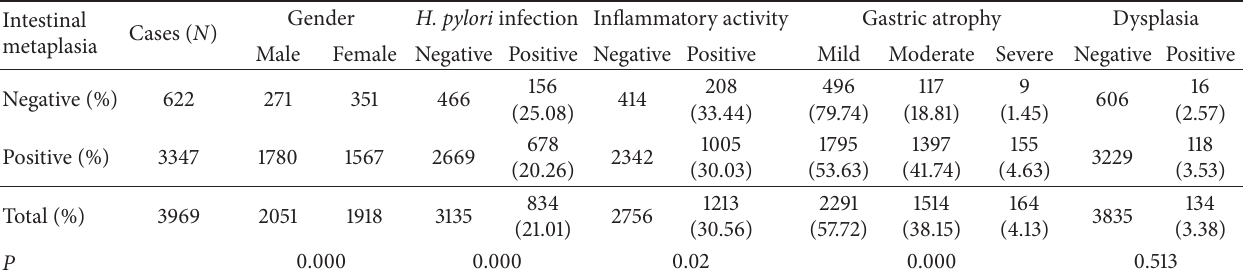
Table 5: The distribution of H. pylori infection, inflammatory (neutrophil) activity, gastric atrophy, and dysplasia according to the presence or absence of intestinal